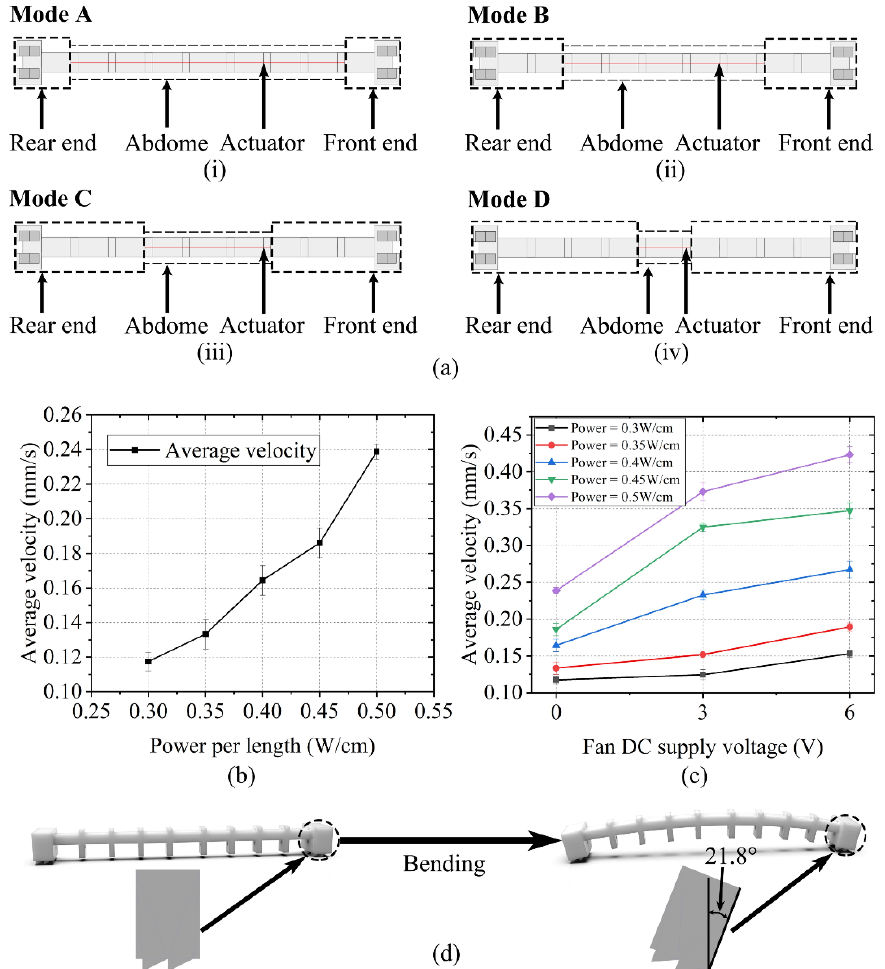
Figure 7. Locomotion velocity test of the crawling robot. ( a ) Four different percentage modes of the front end, rear end, and abdomen (the position marked with red line is the installed location of the actuator). ( b ) Locomotion velocity of the robot at different power inputs under mode C. ( c ) The relationship between the fan DC supply voltage and the robot locomotion rate for different input powers under mode C. ( d ) Threshold angle of the robot’s forefoot geometry to the ground is approximately 21.8°.